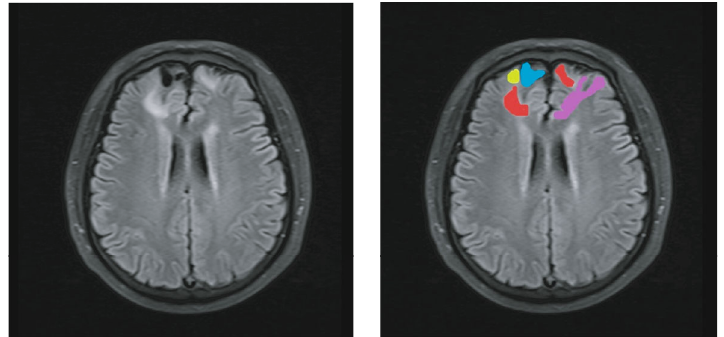
Figure 4: A FLAIR image ROI label example of a 61-year-old man with late epilepsy six months after trauma. Four colors were used: red- labeled FLAIR hyperintense lesion surrounding encephalomalacia; green-labeled FLAIR hypointense lesion surrounding encephalomalacia; blue-labeled encephalomalacia; and purple-labeled contralateral area and adjacent normal